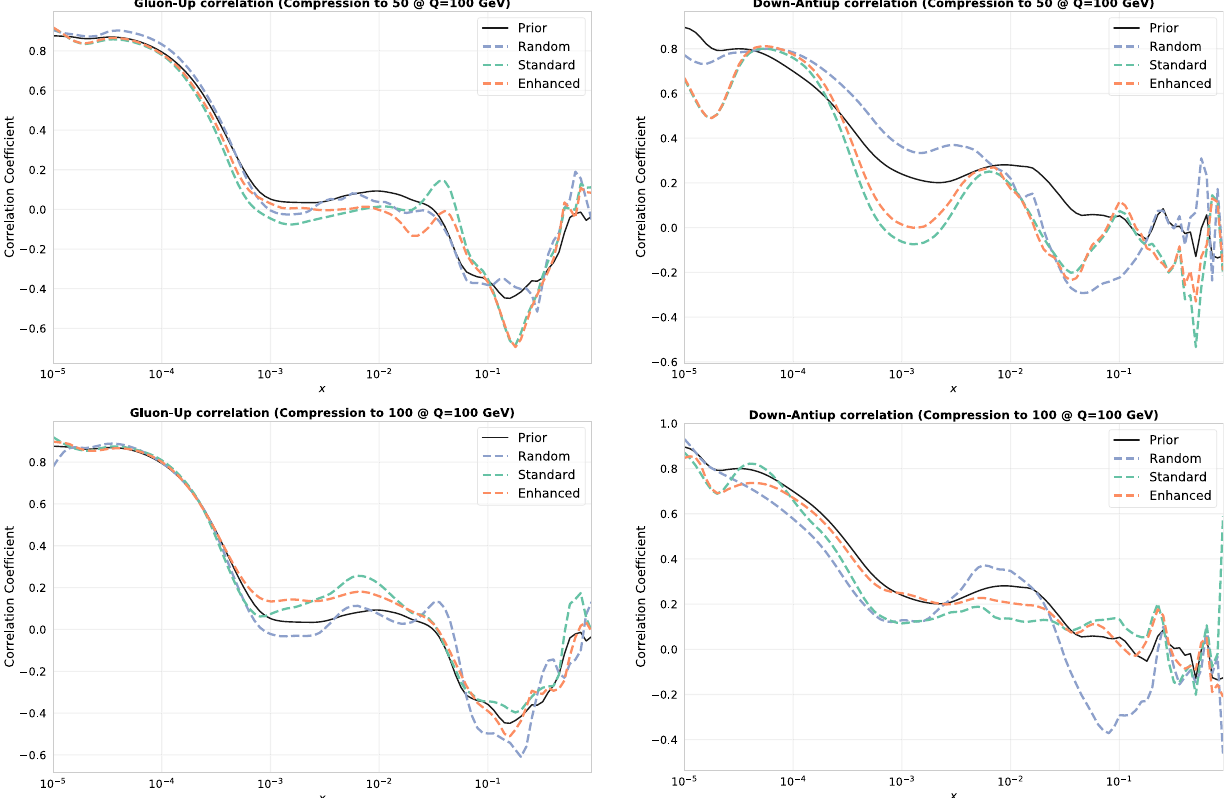
Fig. 12 Correlations between g - u and d - ¯ u PDFs for compressed sets with size N c = 50 (top) and N c = 100 (bottom). The energy scale Q has been chosen to be Q = 100GeV. The correlation extracted from the results of the GAN-compressor (orange) is compared to the results from the standard compressor